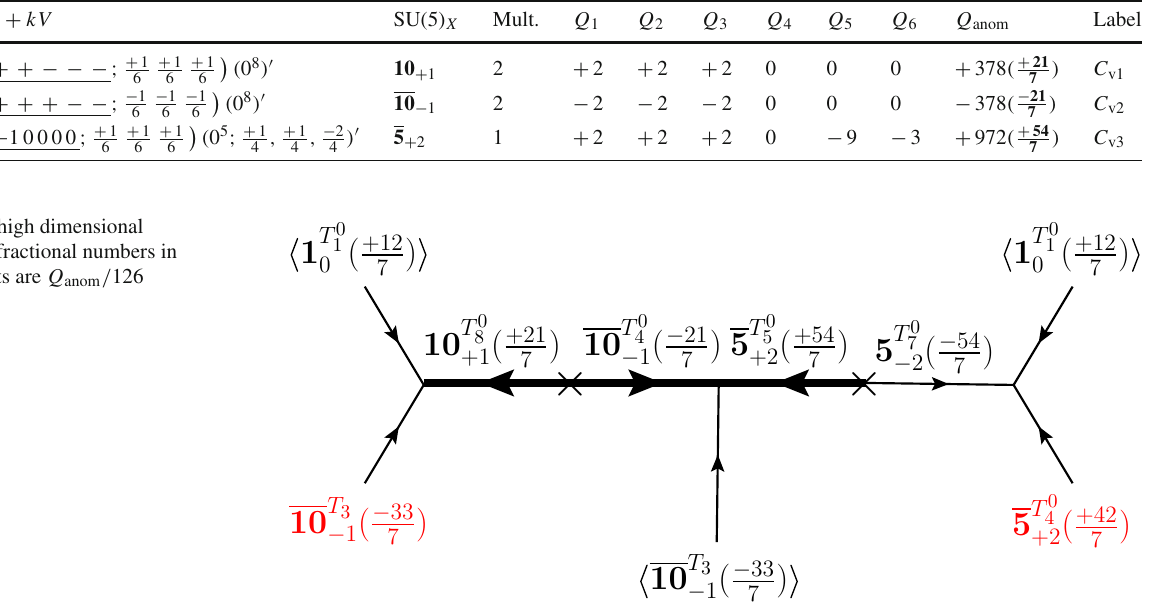
Table 4 Three left-handed states belonging to the vector-like spectrum appearing in Fig. 2 Sect.